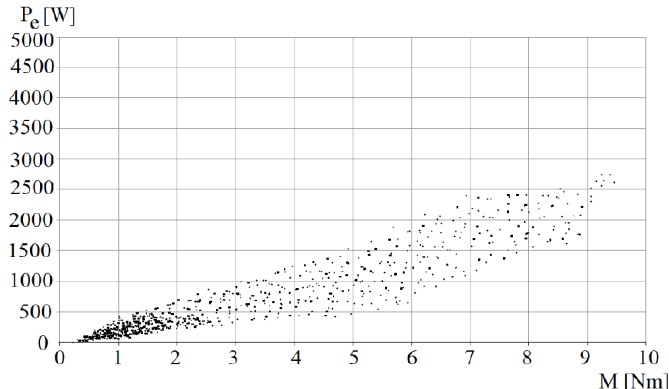
Figure 10. Dependence of the weight G on the torque M.